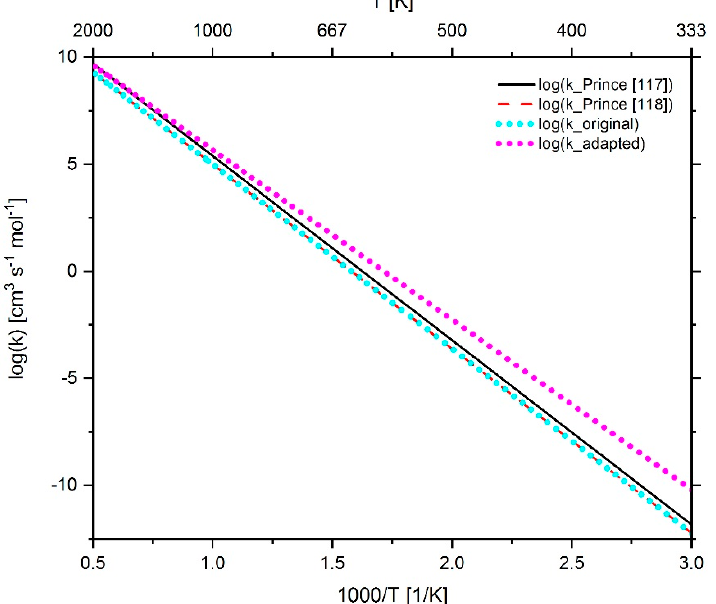
Figure 29. Comparison of the reaction rate coefficient of reaction 300 ( n -C 7 -OQOOH ↔ OH + CH 2 O + CO + C 2 H 4 + n -C 3 H 7 ) before and after adaptation as well as the rate coefficients published by Prince et al. [117,118].